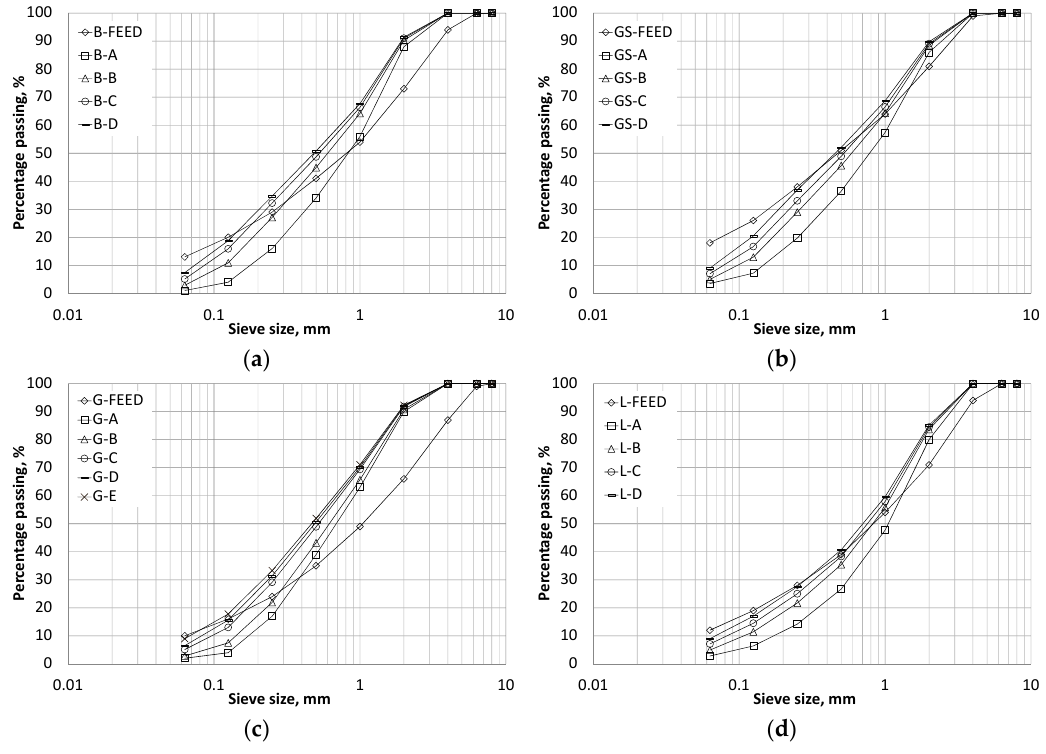
Figure 1. Manufactured sand particle size distributions for ( a ) Basalt sand; ( b ) Gritstone sand; ( c ) Granite sand; ( d ) Limestone sand.